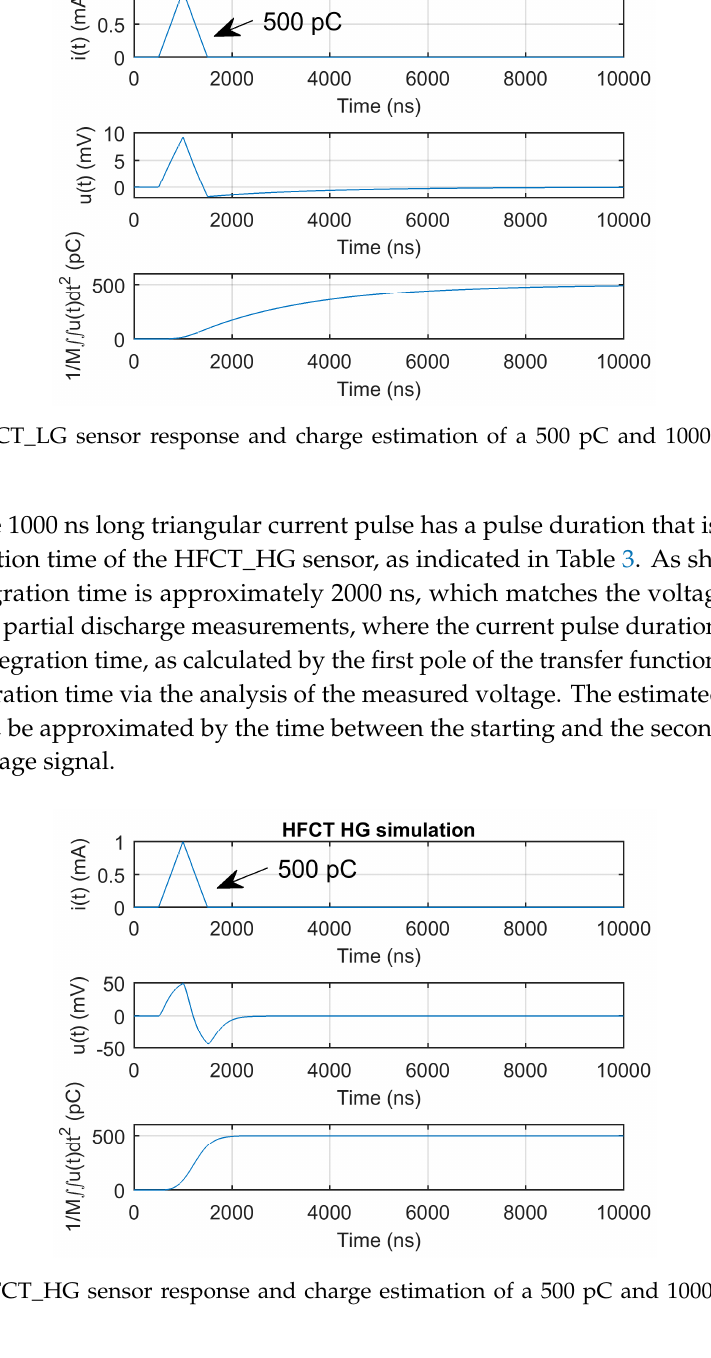
Figure 8. HFCT_HG sensor response and charge estimation of a 5 pC and 10 ns triangular current pulse.